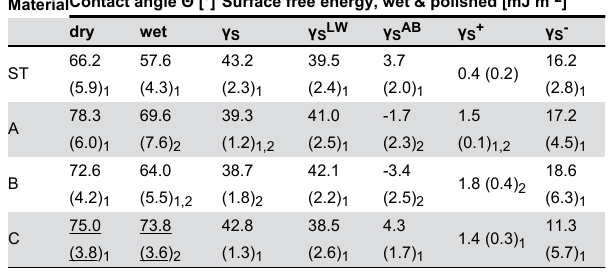
Table 4. Means and (standard deviations) of contact angles and surface free energies of dry stored and wet stored polished specimens, values are rounded to valid